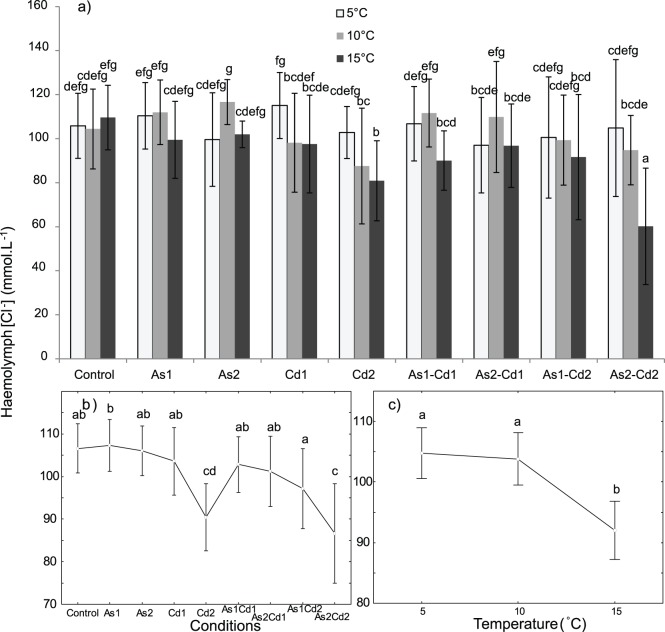
Mean concentrations of haemolymphatic [Cl−](mmol L−1) in Gammarus pulex.
Concentrations obtained for individuals exposed 96 h to different conditions (control, arsenate, cadmium and four binary mixtures) at three temperatures (5-10-15°C). a)
Temperature × condition effect: Mean haemolymphatic [Cl−] for each tested condition and temperature. Vertical bars represent standard deviations. b)
Condition effect: Weighted mean haemolymphatic [Cl−] for each tested condition (results for all the tested temperatures were combined). Vertical bars represent 0.95 confidence intervals. c)
Temperature effect: Weighted mean haemolymphatic [Cl−] for each temperature (results for all the tested temperatures were combined). Vertical bars represent 0.95 confidence intervals. Letters (a to g) were used as labels to illustrate significant differences in values of mean haemolymphatic [Cl−] (two-way ANOVAs + LSD Fisher post hoc tests; at p<0.05 level of significance).